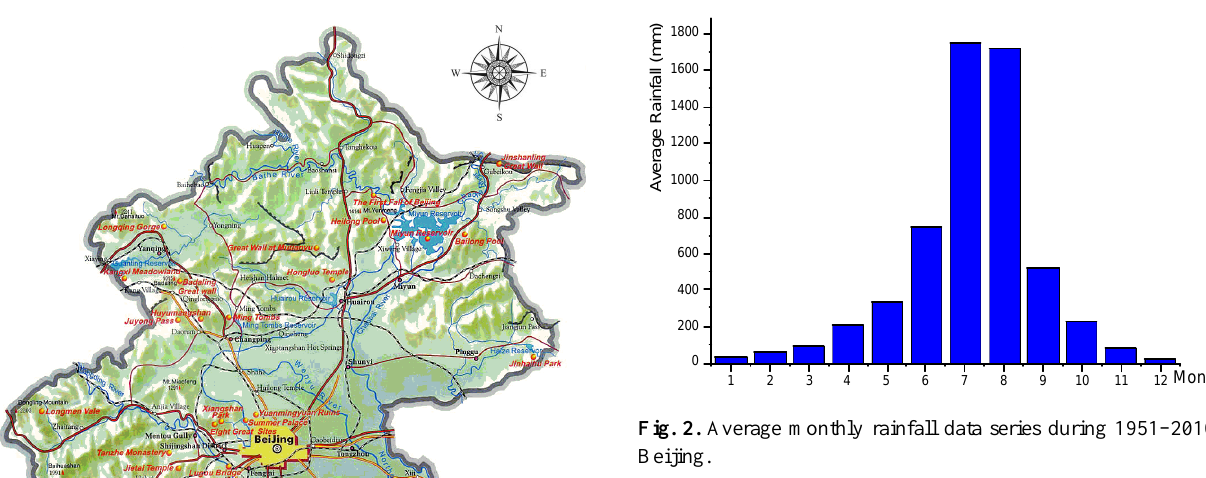
Fig. 3. The data series of the total population and the proportion of urban population of Beijing during